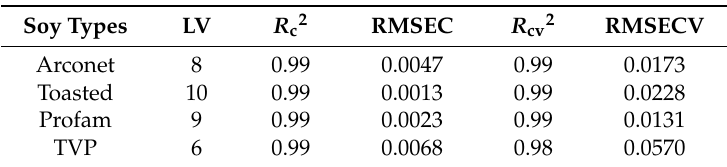
Table 2. Results of PLS regression based on FT-NIR spectral data, FT-NIR: Fourier transform near-infrared spectroscopy.